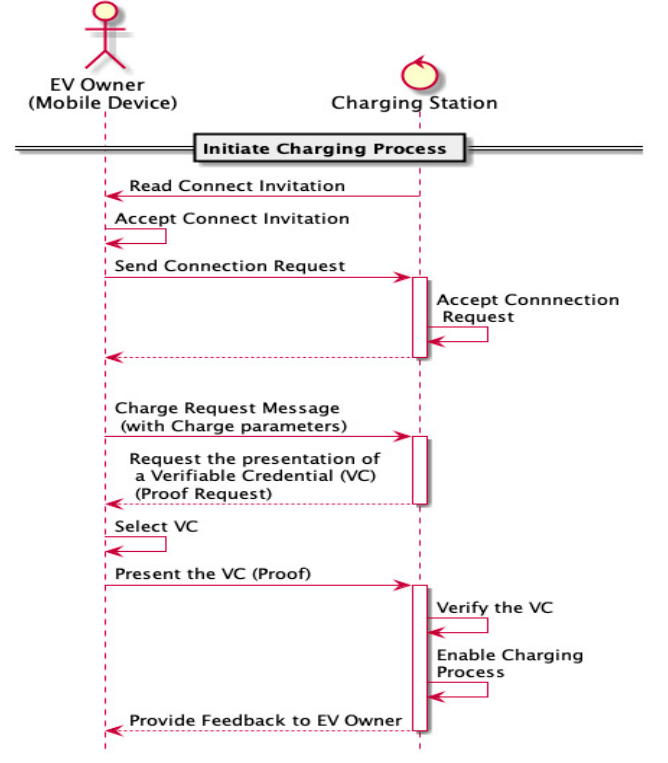
Figure 4. Charging process sequence diagram.